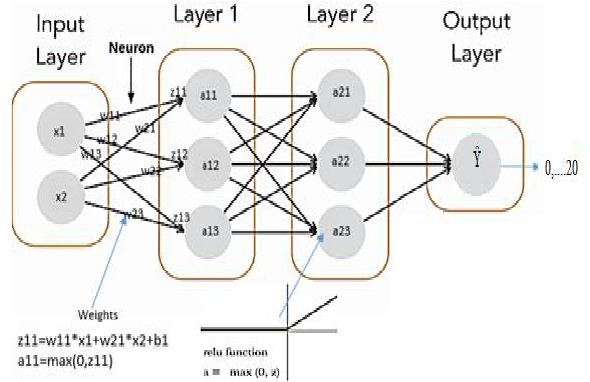
Figure 4 Example of a Neural Network Structure implemented using the Keras.